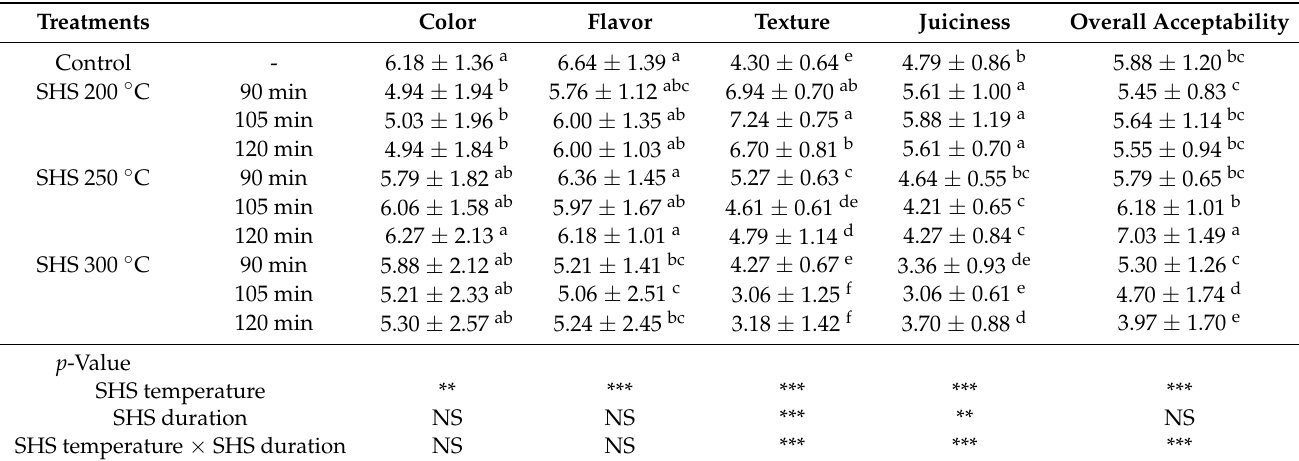
Table 4. Sensory evaluation in semi-dried restructured jerky processed with super-heated steam (SHS). Treatments